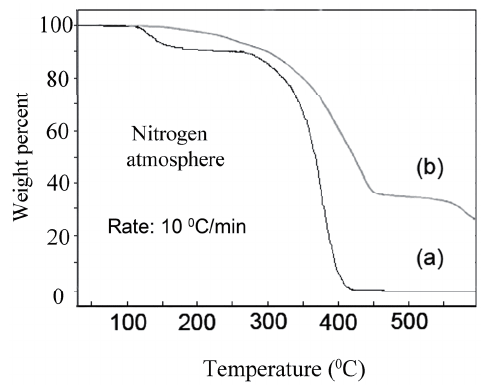
Figure 8. FT-IR spectrum of (a) Sb 2 O 3 , (b) PS/Sb 2 O 3 -Br, (c) CA/Sb 2 O 3 -Br.